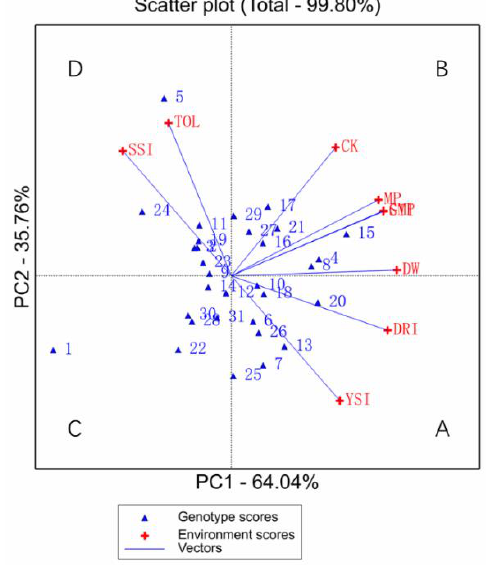
Figure 3. GGE biplot graphic based on the two first principal components for 31 inbred lines of maize and different drought tolerance indices. Numbers assigned to the genotypes Are: (1) KA008; (2) 2012KA-1; (3) KA064; (4) KA105; (5) KA103; (6) KA203; (7) 2012KA-34; (8) 91227; (9) KA227; (10)